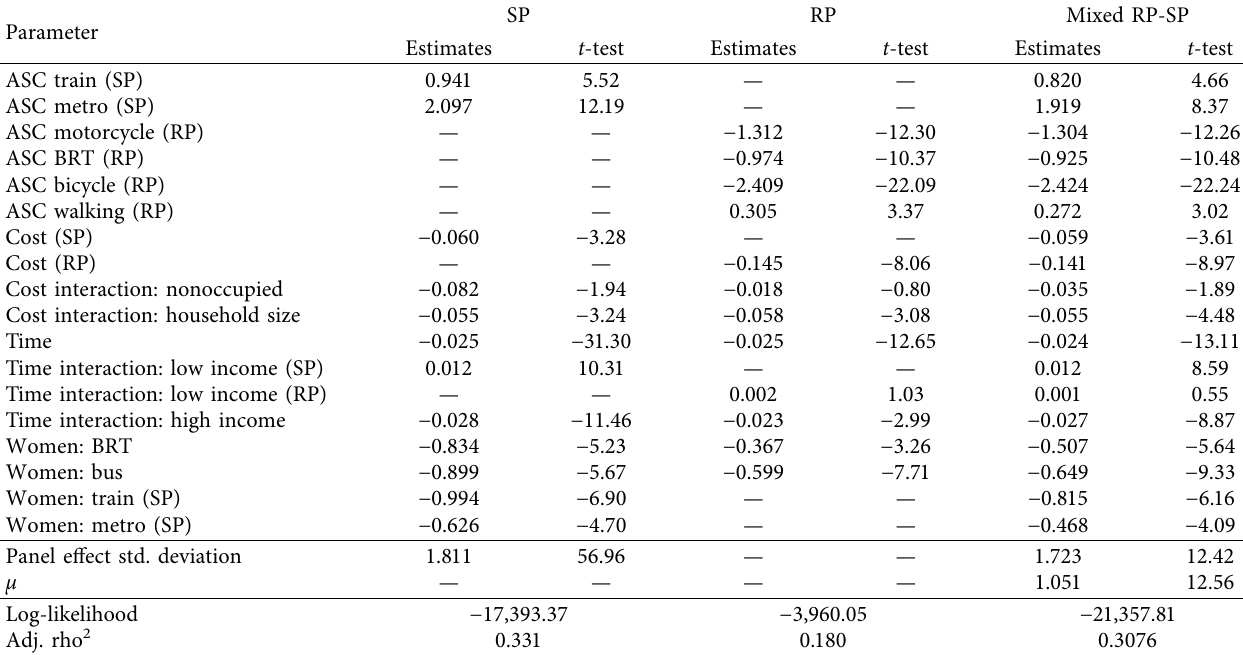
Figure 2: Comparison of potentially common parameters, SP vs. Table 5: Model estimation results.